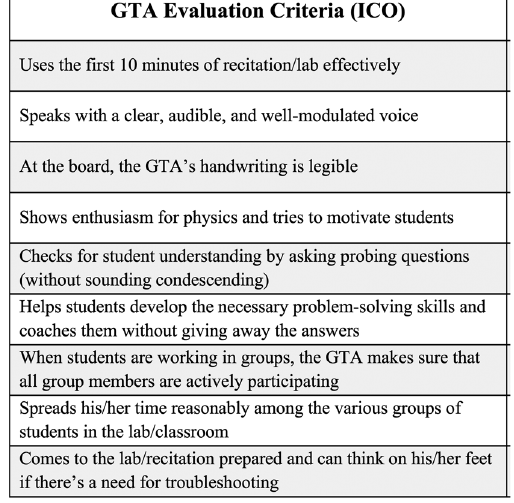
FIG. 5. Evaluation criteria for the individual classroom obser- vations (ICO). Each criterion is evaluated in a four-point scale: excellent, good, just OK, need to